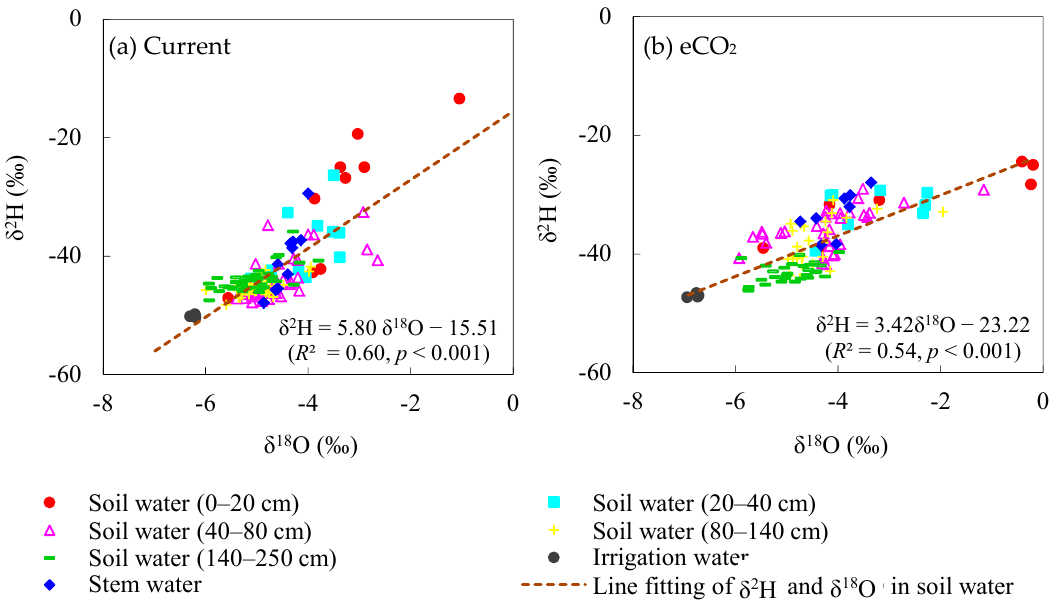
Figure 4. Isotopic values of stem water, irrigation water, and soil water in different layers under ( a ) current and ( b ) eCO 2 treatments, respectively.